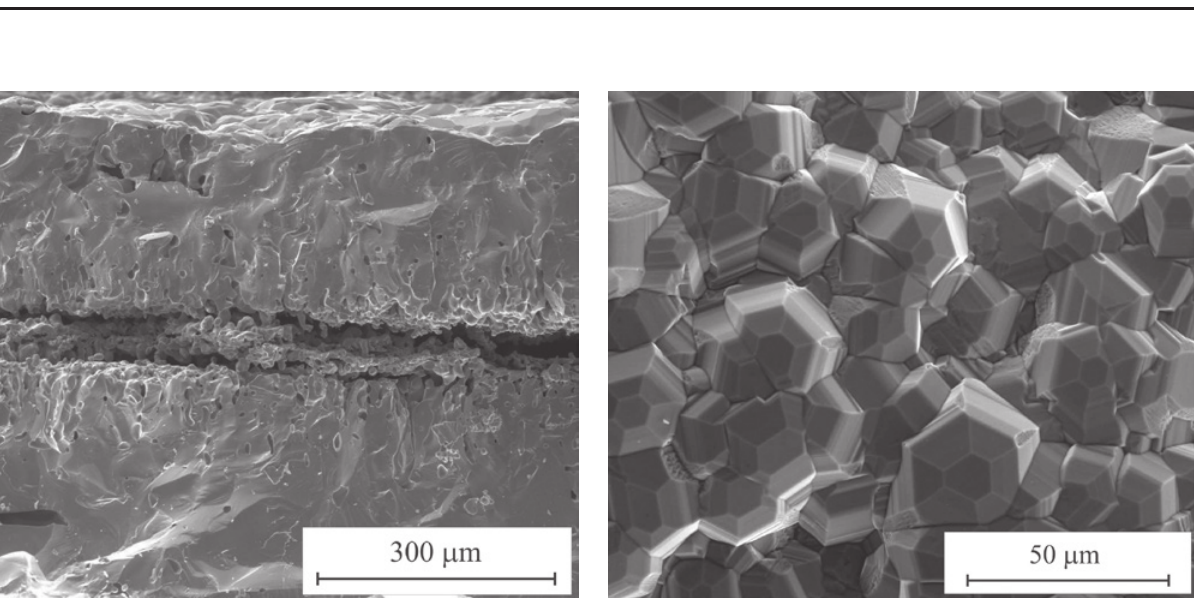
Fig. 3: The microphotograph of the surface of the NiS sulphide after complete sulphidation of flat Ni sample at 873 K and sulphur vapor pressure equal 100